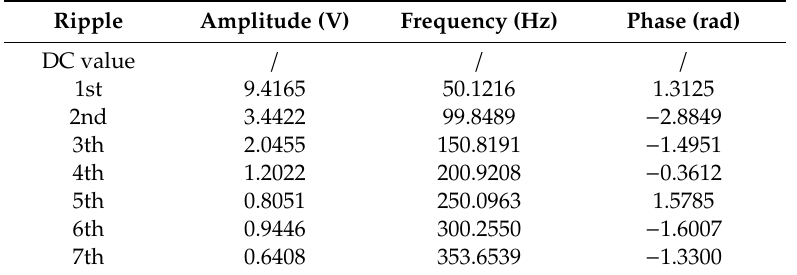
Table 8. Measured ripple components based on window interpolation FFT (WIFFT)